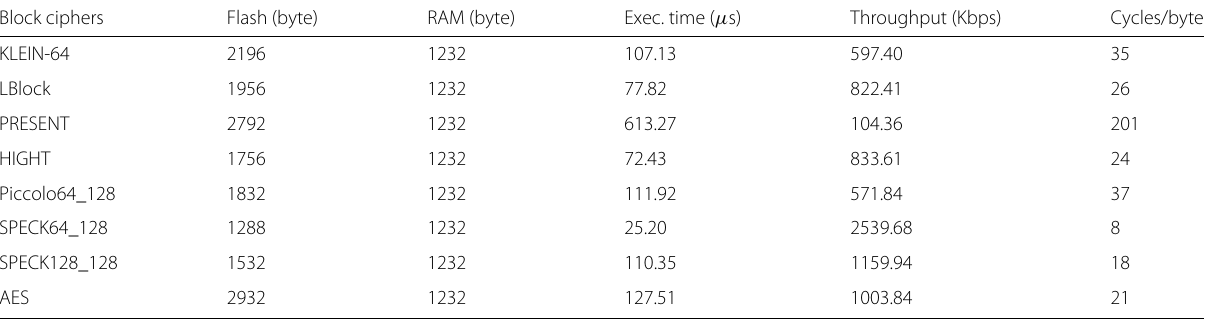
Table 8 Performance of mode